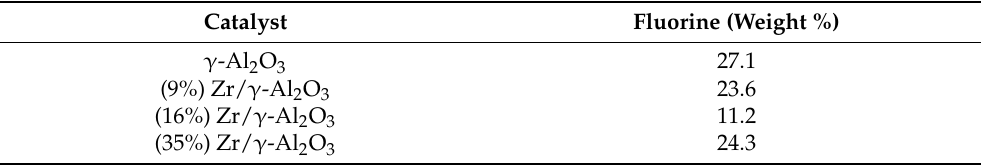
Table 4. EDS analysis of used catalysts.